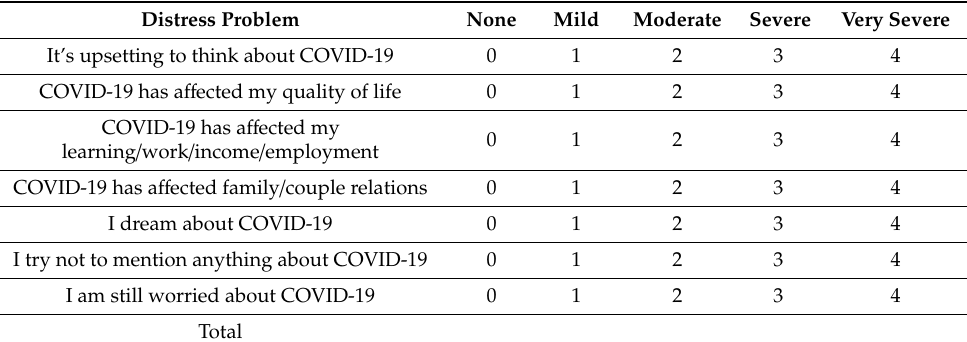
Table A4. Revised Event Impact Scale